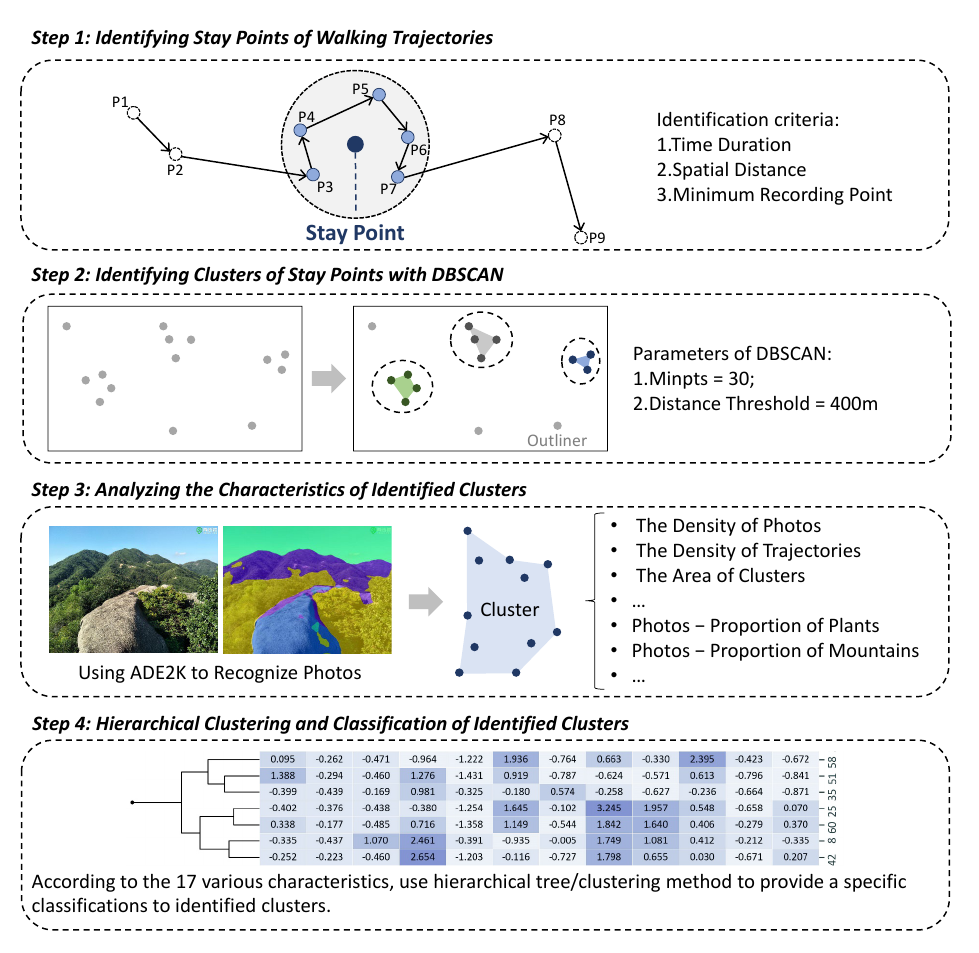
Figure 2. Overview: methodological flowchart.